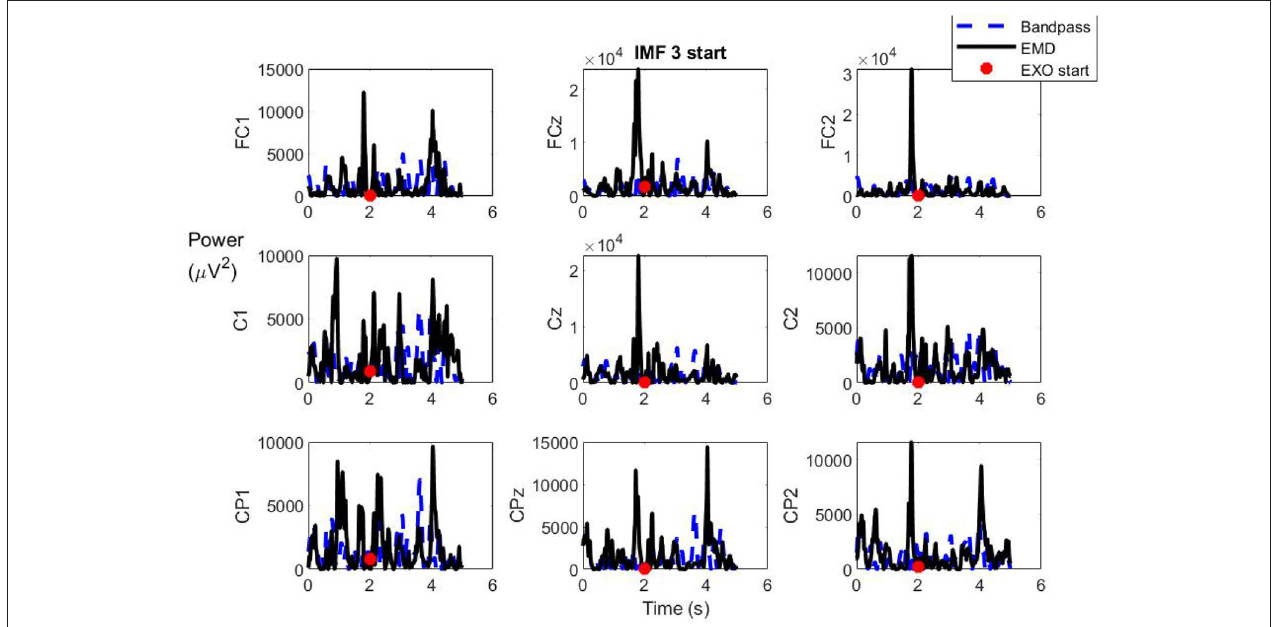
FIGURE 6 | Instantaneous power of IMF3 after the acoustic cue for MI (black line) for trial 1 of subject S1. The value is compared with the instantaneous power of the signal filtered by a Butterworth filter (5–15 Hz). The peak response is higher using the IMF. REX start of movement is represented by a red spot.